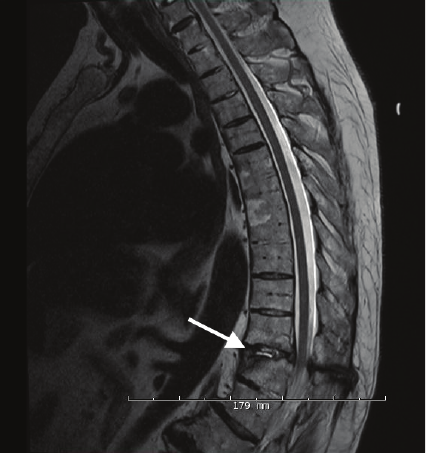
Figure 1: T2 thoracic MRI showing focal signal abnormality at the T11-T12 level (white arrow) with associated edema and loss of disc height, in addition to moderate spinal canal